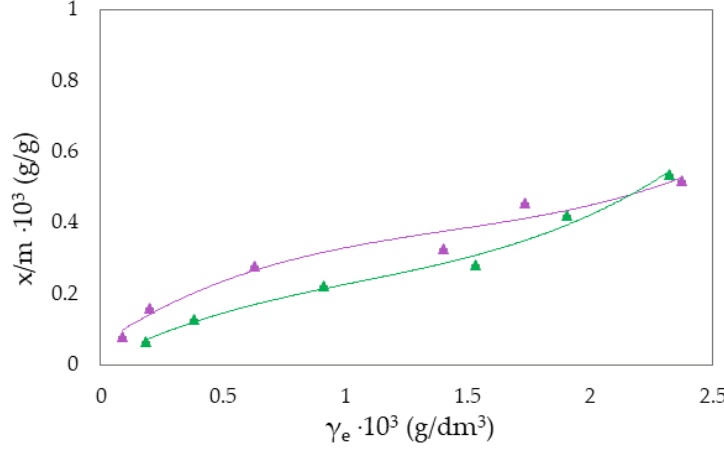
Figure 2. Freundlich adsorption isotherm curves for the suspension RB-NH 4 ZSM-5 at ▲ 283 K and ▲ 293 K.